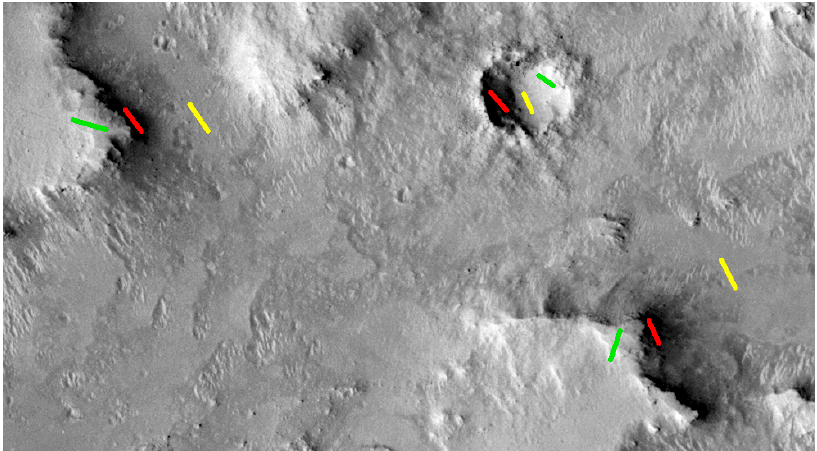
Figure 2. The schematic diagram of the selection of the shadowed and the adjacent sunlit areas (The image is part of the HiRISE image ESP_013855_1650. The red line indicates shadowed areas, the yellow line indicates flat sunlit areas, and the green line indicates the sunlit areas with obvious slope).